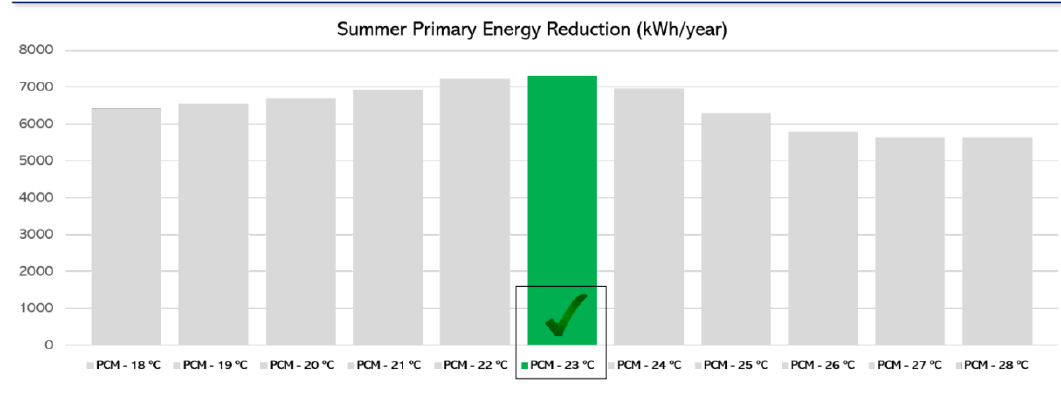
Figure 16. Comparing PCM additions in terms of summer primary energy reduction.